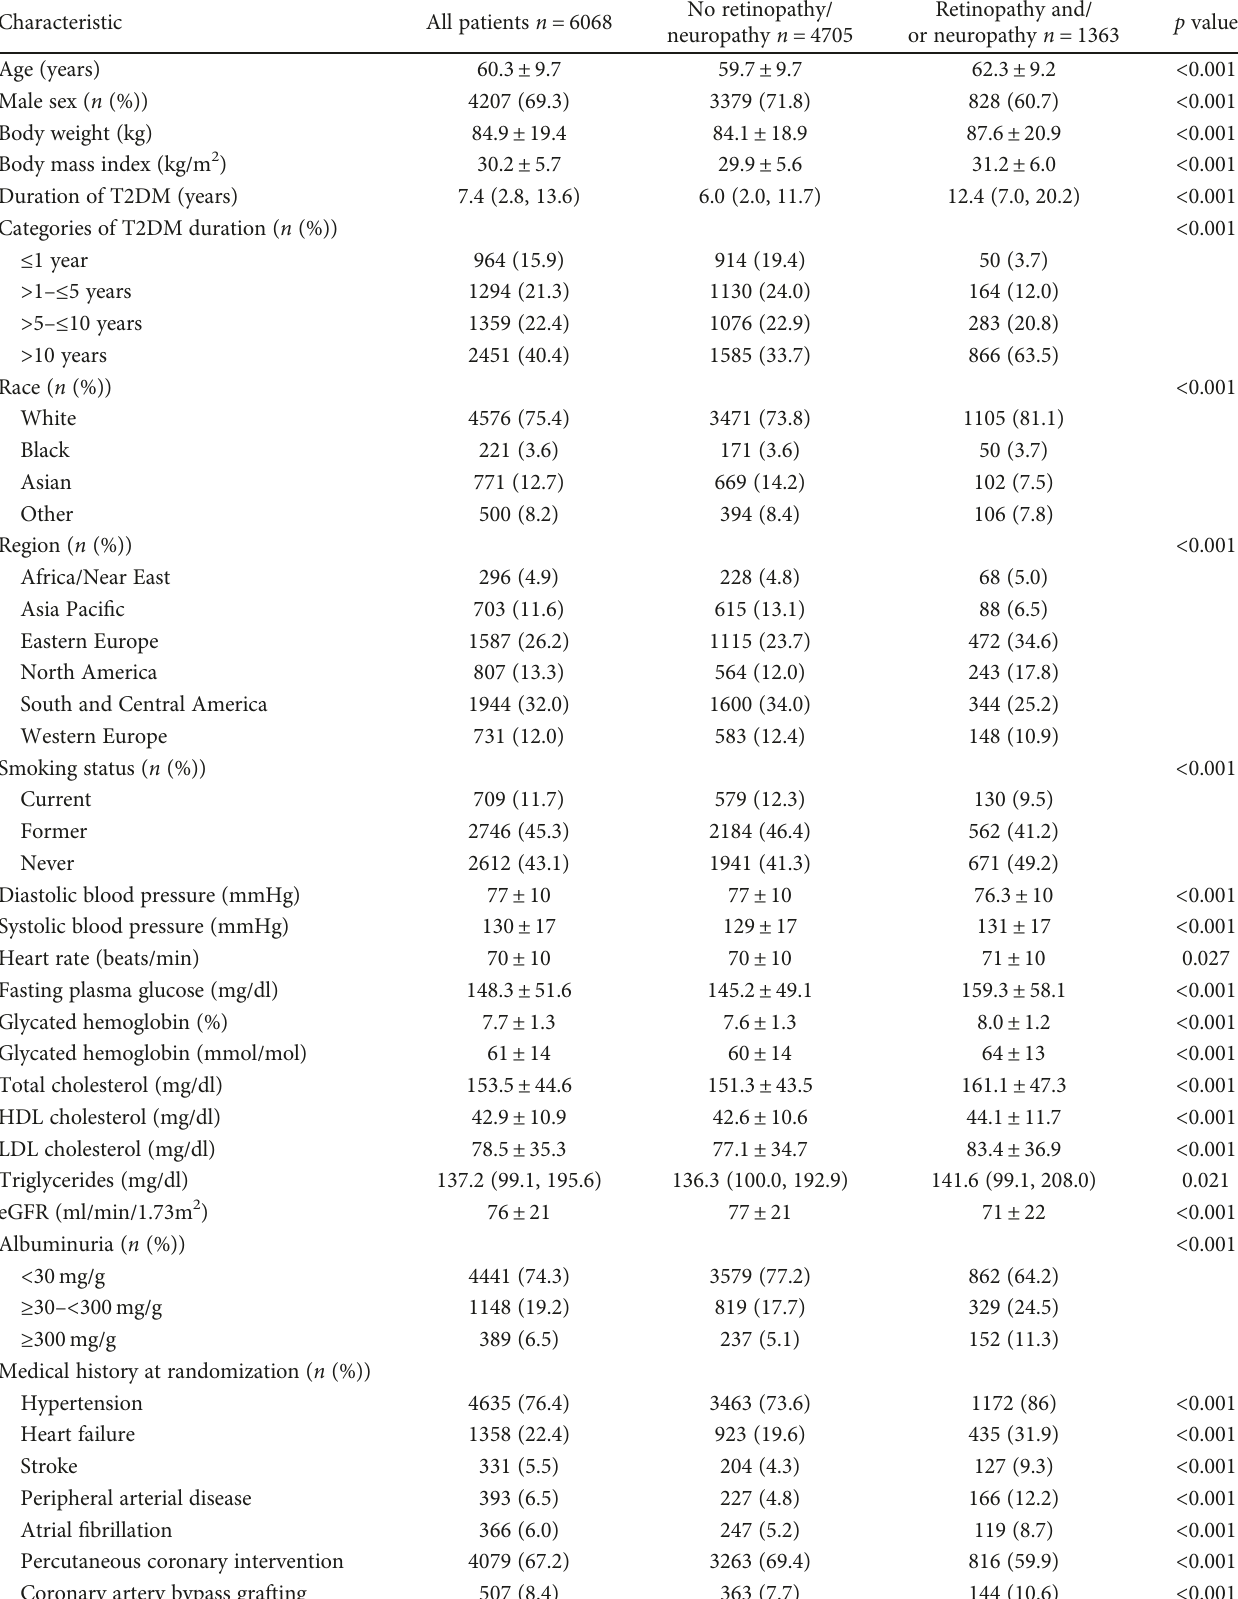
Table 1: Characteristics of all patients at baseline according to the presence of retinopathy and/or